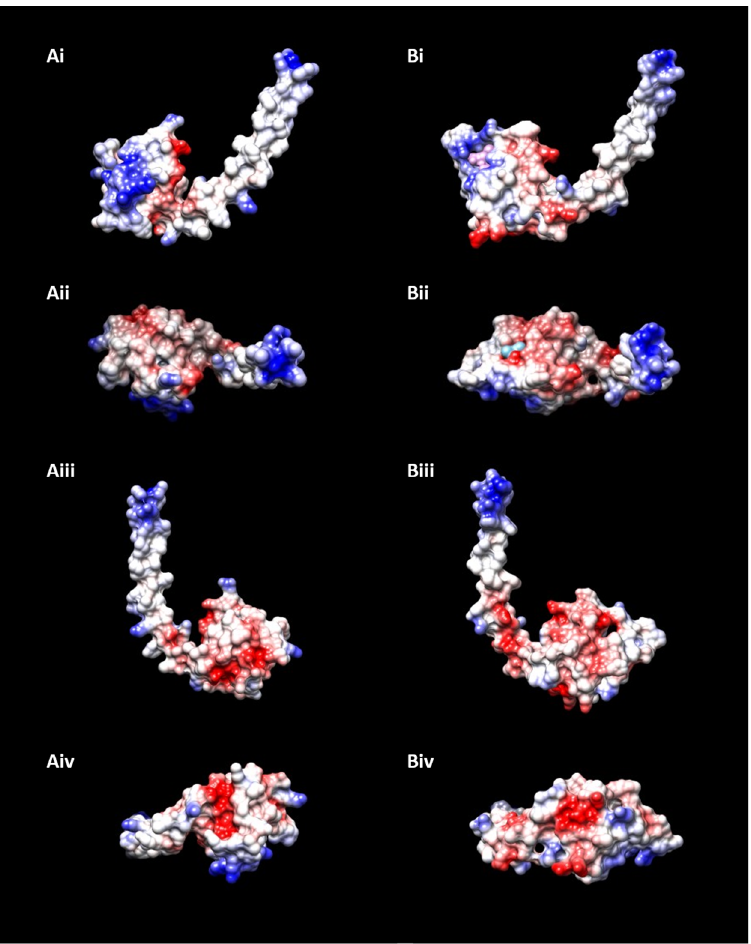
Figure 4. Predicted surface electrostatic potential of Cyt c M and NorC. Cyt c M (the same as in Figures 2 and 3) is represented in ( A ), whereas NorC (the same as in Figure 3) is represented in ( B ). The displayed POVs are front (i), top (ii), back (iii) and bottom (iv). The color code is as customary, with a blue-positive/red-negative/white-neutral palette.